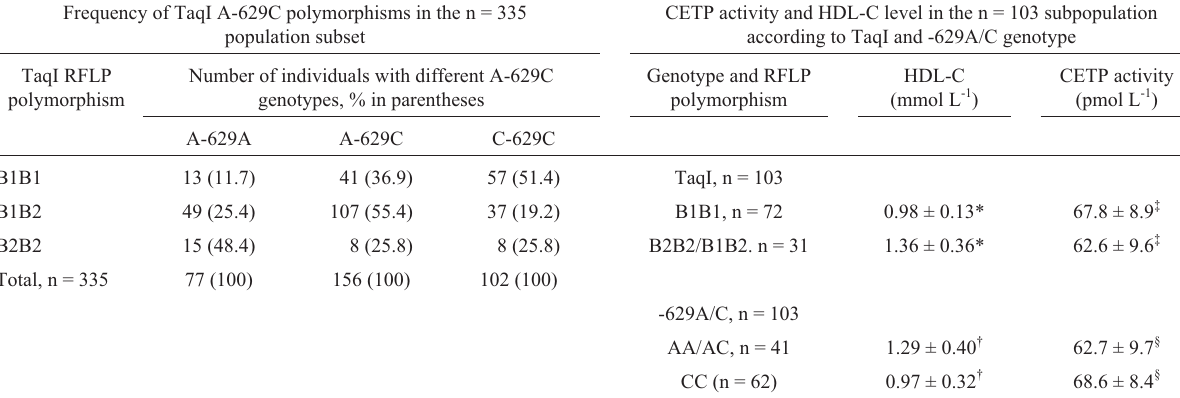
Table 4 - The cholesterol ester transfer protein (CETP) TaqI and A-629C polymorphism distribution in the n = 335 subset plus the high-density lipopro- tein cholesterol (HDL-C) level and expressed CETP activity in the n = 103 subpopulation according to the type of TaqI B1/B2 and -629A/C restriction fragment length polymorphism